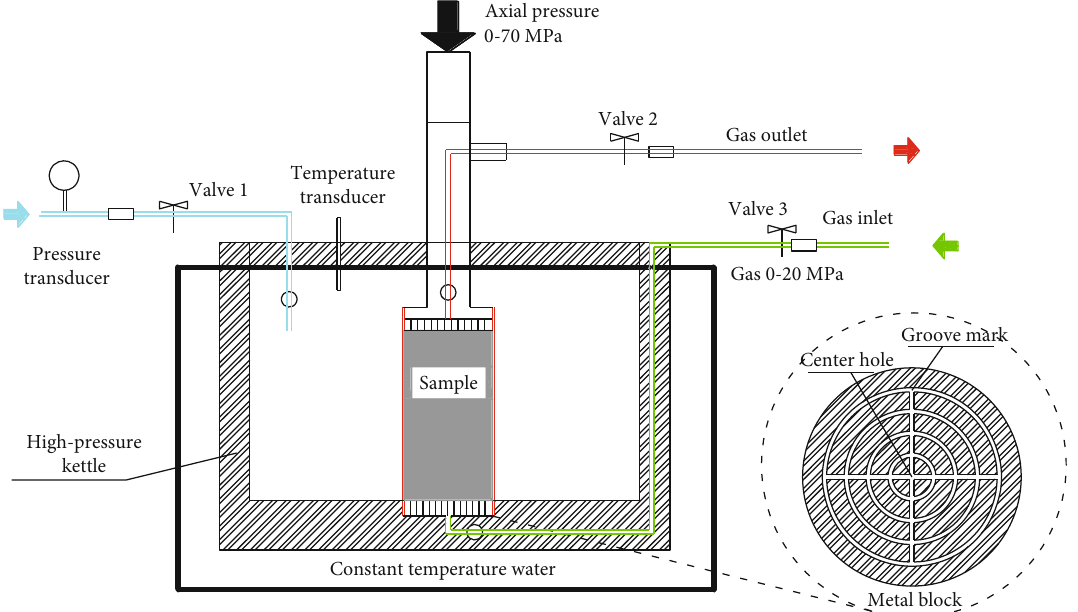
Figure 1: Gas fl ow and displacement testing equipment